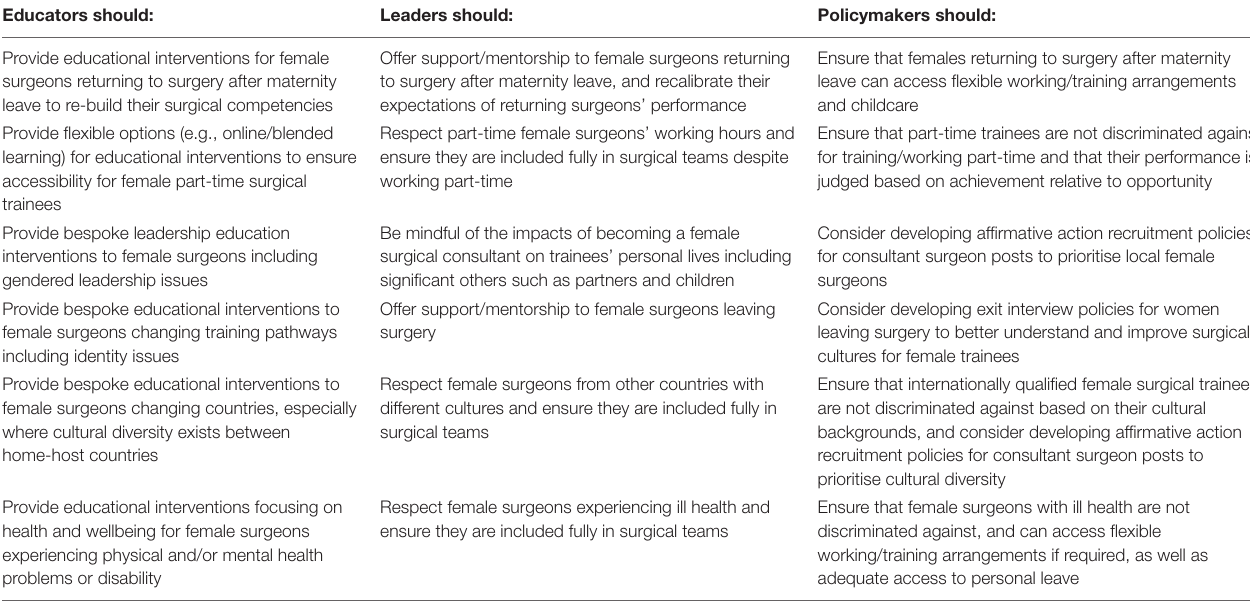
TABLE 3 | Recommendations for educators, leaders and policymakers based on themes. Educators should: Leaders should: Policymakers